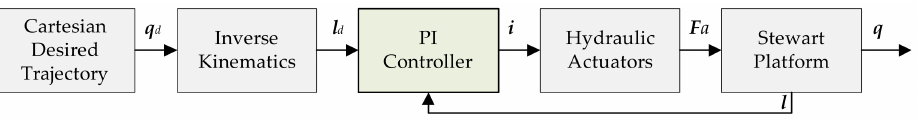
Figure 7. Control block diagram for Stewart platform.